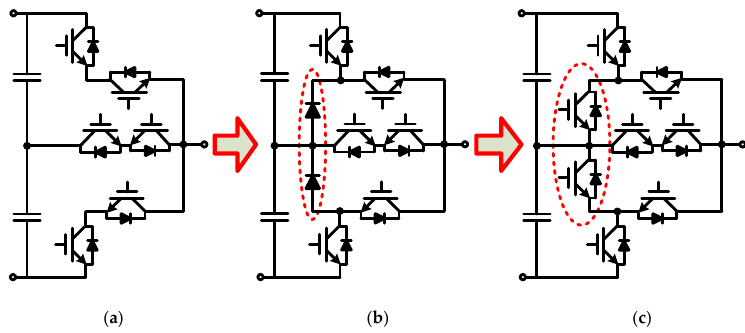
Figure 4. Derivation process of 3L active stacked NPC converters. ( a ) 3L stacked converter [28], ( b ) 3L stacked NPC converter [29], ( c ) 3L active stacked NPC converter [30].